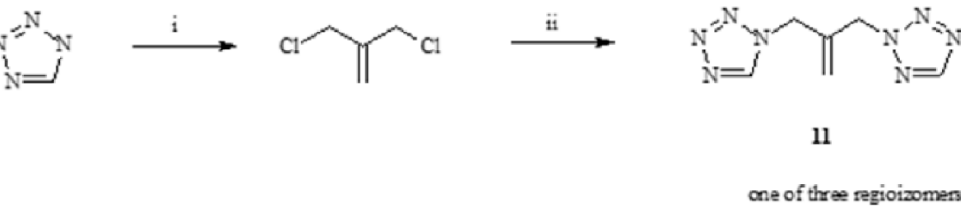
Figure 9. Scheme of synthesis of 1-[2-(2H-tetrazol-2-ylmethyl) prop-2-en-1-yl]-1H-tetrazole( 11 ). i—sodium, methanol, ii—acetonitrile, reflux.